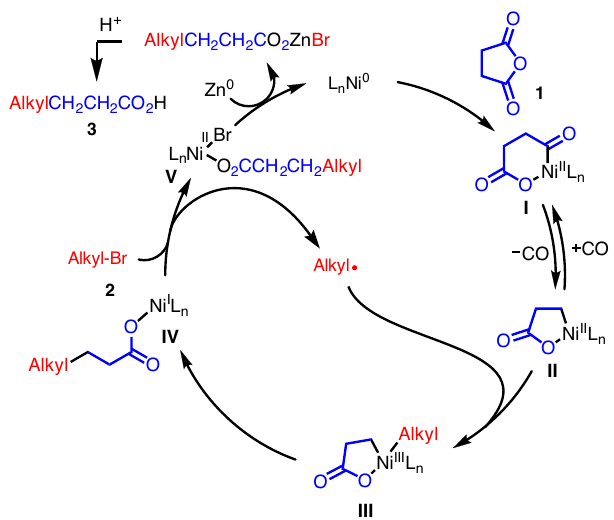
Fig. 6 Mechanistic hypothesis. Oxidative addition of anhydride ( 1 ) is followed by loss of carbon monoxide to generate homoenolate II . Oxidative capture of the alkyl radical formed Ni(III), which reductively eliminates to form Ni(I) intermediate IV . The Ni(I) intermediate is proposed to reduce the alkyl bromide 2 to furnish the alkyl radical and Ni(II) intermediate V . Zinc reduction of Ni(II) reforms Ni(0) and produces a zinc carboxylate, closing the catalytic cycle. Upon workup, the zinc carboxylate is protonated to give the observed carboxylic acid product 3